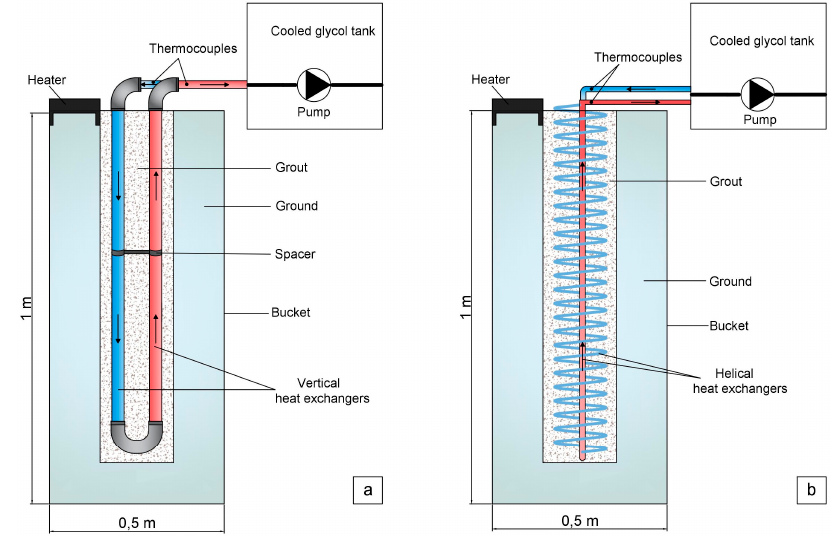
Figure 1. Schema of the vertical borehole heat exchanger reproduced in laboratory. ( a ) Vertical heat exchangers; ( b ) helical heat exchangers.